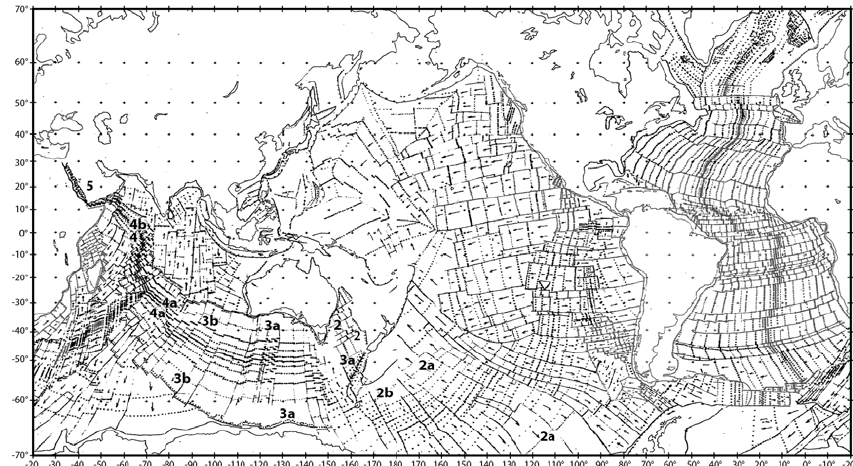
Figure 11. Mercator map of oceanic magnetic anomalies and transform faults. Scanned copy of the original 1986 illustration.